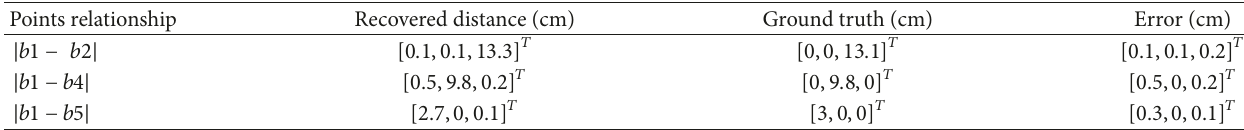
Table 2: The relative location relationship between eight corner